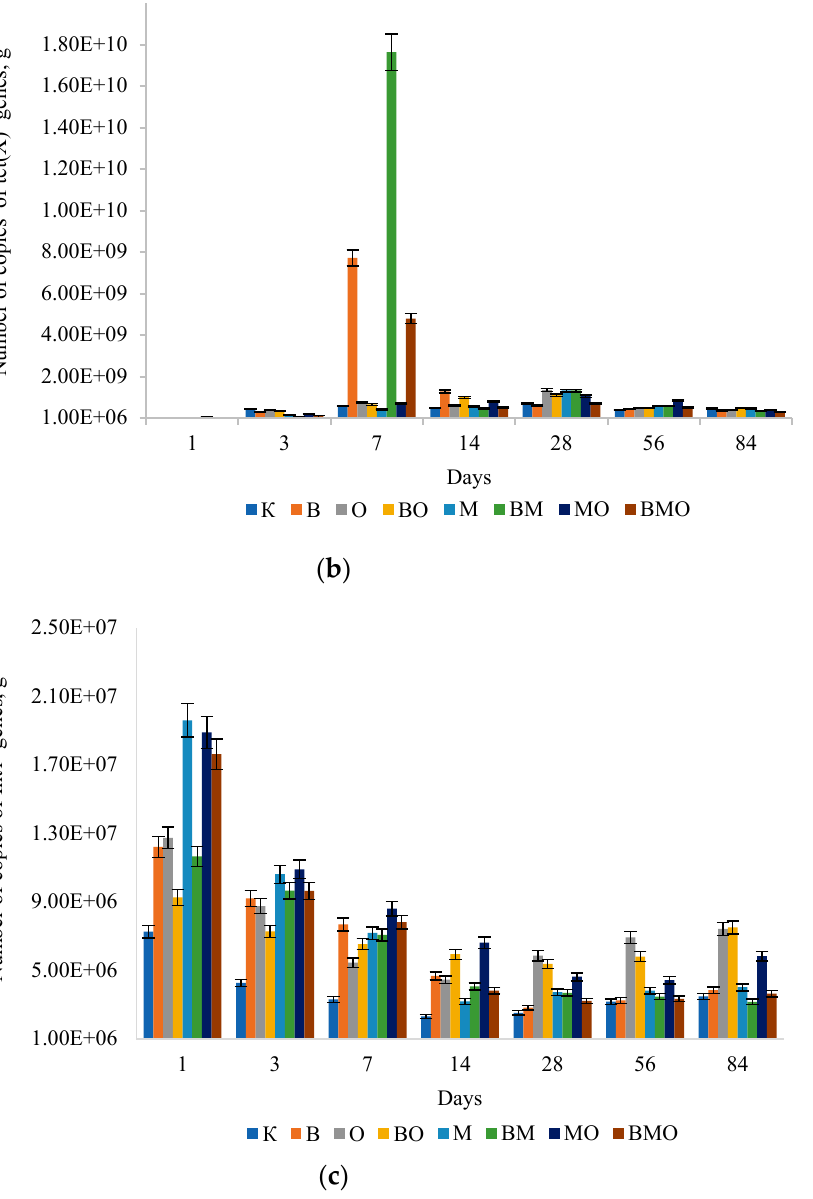
Figure 3. Number of copies of the tet (A) gene ( a ), tet (X) gene ( b ), and the gene encoding integron class A ( int1 ) ( c ) in the composting mixtures.